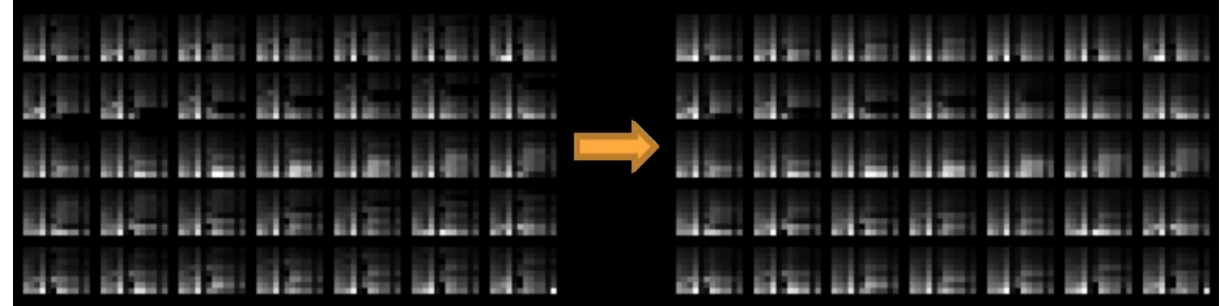
Figure 7. Convolutional autoencoder (CAE) reconstruction results of the learned CAE for one random subject.